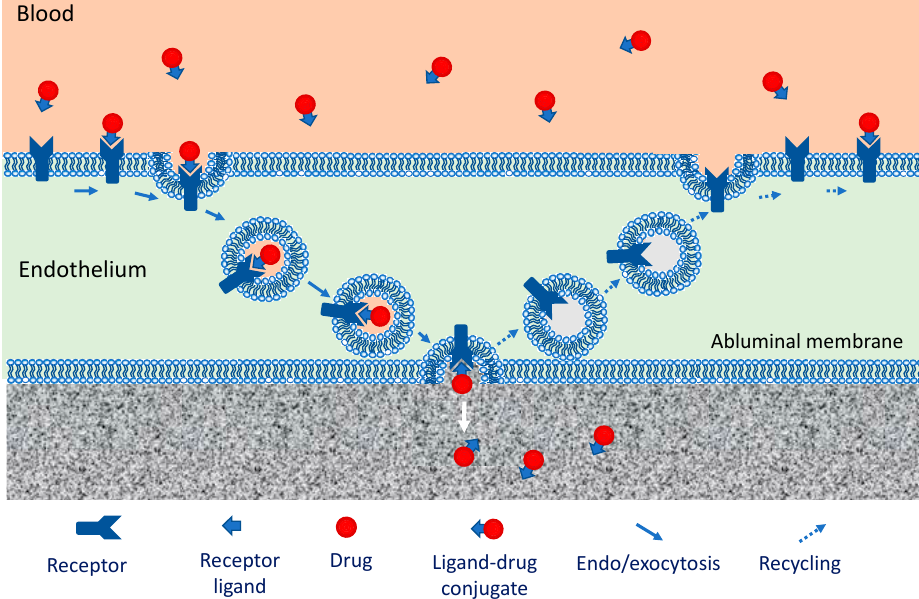
Figure 3. Receptor-mediated transcytosis (RMT) as a means to enhance drug delivery to brain tumors. This figure shows how receptors that are expressed on endothelial cells of the BBTB can be exploited to enhance drug delivery to the brain tumor. A selected ligand (peptide or antibody) against a given receptor (a recycling receptors as, e.g., the transferin receptor-TfR) is conjugated to a drug. The ligand-drug conjugated in the blood-stream is internalized through endocytosis and externalized into the brain tumor tissue through exocytosis. The receptor is then recycled to the luminal surface of the endothelial cell.